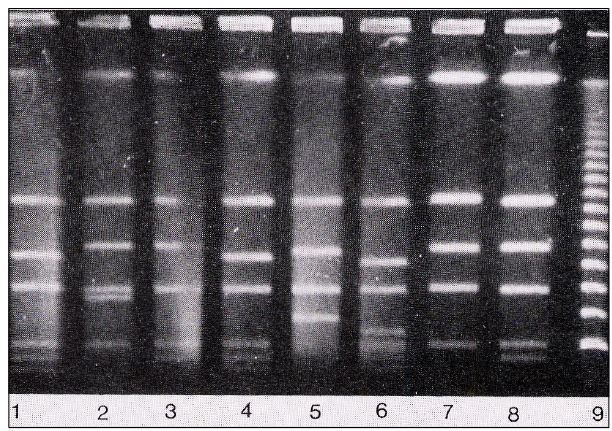
Fig ure 1) Pulsed field gel elec tro pho re sis of SmaI cleaved ge nomic DNA of eight epi de mi ol ogi cally un re lated strains of Mo rax ella ca tar - rhalis from di verse geo graphi cal ar eas in clud ing Swe den, Great Brit - ain, Texas and five Ca na dian prov inces. Lane 9 shows lambda lad der pulsed field gel mo lecu lar size